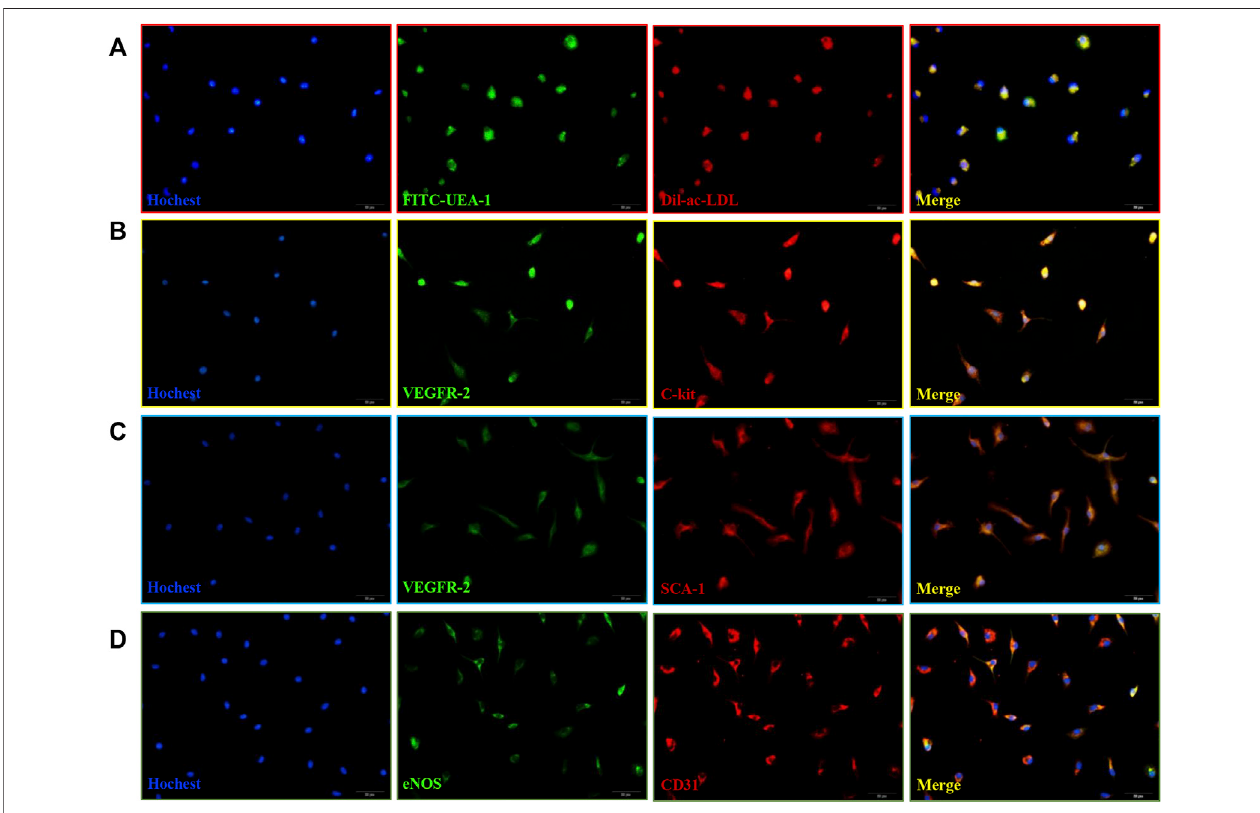
FIGURE1 | Isolation and characterization ofmice bone marrow-derived EPCs. (A) DiI-ac-LDL (red) and FITC-UEA-1 (green) could be taken up byEPCs (blue) and merged images of red and green fl uorescence. Scale bar = 20 μ m (400x). (B) Co-expression of VEGFR-2 (green) with C-kit (red) in cells at 10 d. (C) Co-expression of VEGFR-2 (green) with SCA-1 (red) in cells at 10 d. (D) Co-expression of eNOS (green) with CD31 (red) in cells at 21 days. Scale bar = 20 μ m (400x).